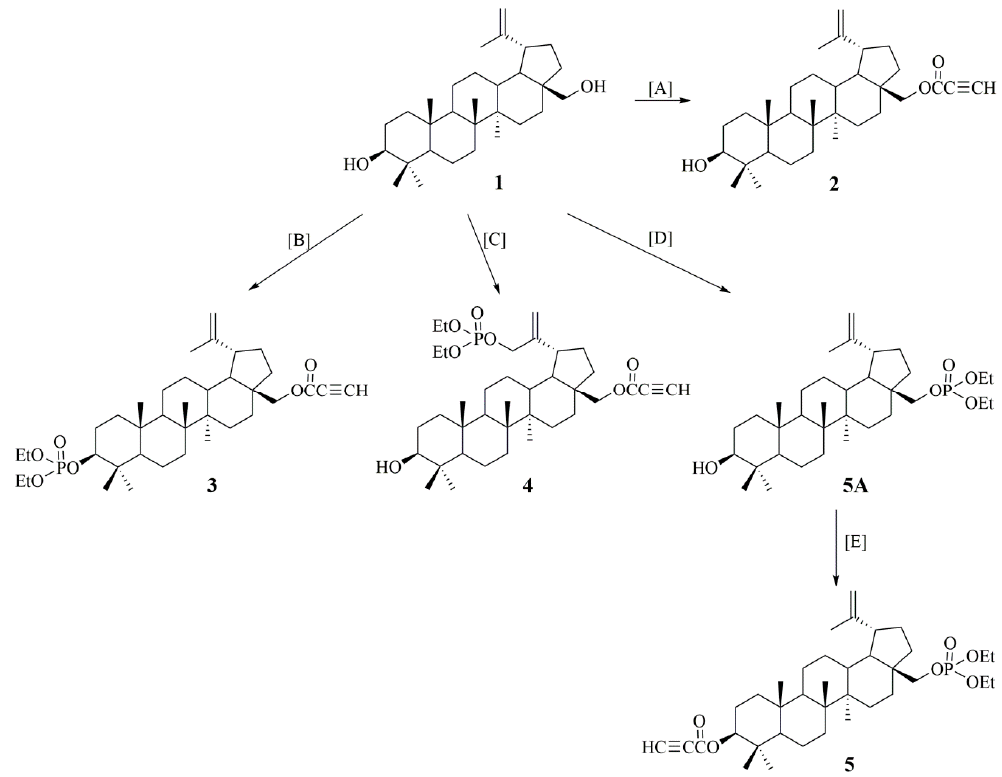
Figure 10. Synthesis pathways of betulin derivatives ( 2 – 5 ), used reagents and reaction conditions. A: propiolic acid, dicyclohexylcarbodiimide (DCC), 4-dimethylaminopyridine (DMAP), CH 2 Cl 2 , − 10 °C—r. t. [25] ; B: (i) acetic anhydride {(CH 3 CO) 2 O}, pyridine, CH 2 Cl 2 , r. t. (ii) diethylchlorophosphate {(EtO) 2 P(O)Cl}, DMAP, pyridine, r. t. (iii) NaOH, tetrahydrofuran (THF), H 2 O, methanol, r. t. (iv) propiolic acid, DCC, DMAP, CH 2 Cl 2 , − 10 °C—r. t. [35] ; C: (i) (CH 3 CO) 2 O, pyridine, CH 2 Cl 2 , r. t. (ii) m-chloroperbenzoic acid (m-CPBA), CHCl 3 , reflux. (iii) (EtO) 2 P(O)Cl, DMAP, pyridine, r. t. (iv) NaOH, THF, H 2 O, methanol, r. t. (v) propiolic acid, DCC, DMAP, CH 2 Cl 2 , − 10 °C—r. t. [34] D: (EtO) 2 P(O)Cl, DMAP, THF, r. t. [36] ; E: propiolic acid, DCC, DMAP, CH 2 Cl 2 , − 10 °C—r. t.